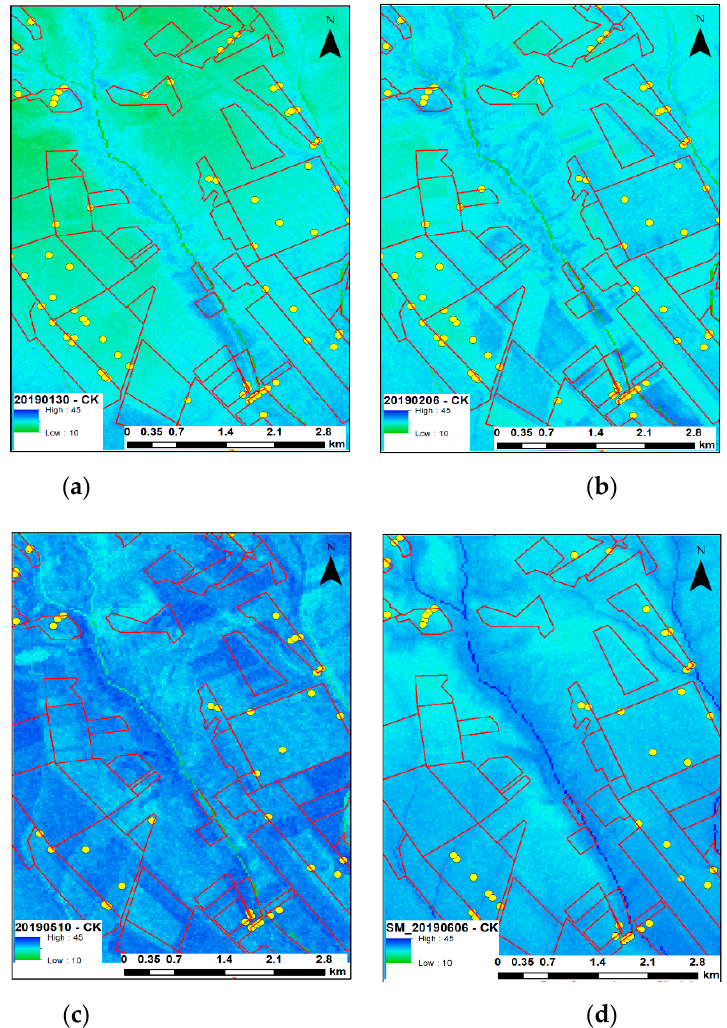
Figure 11. All land uses: Ordinary cokriging soil moisture— ( a ) January 2019, ( b ) February 2019, ( c ) May 2019, and ( d ) June 2019, respectively.